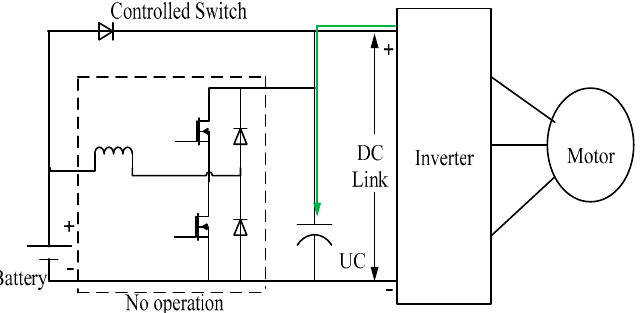
Figure 9. Regenerative braking when V UC > V UC_target .